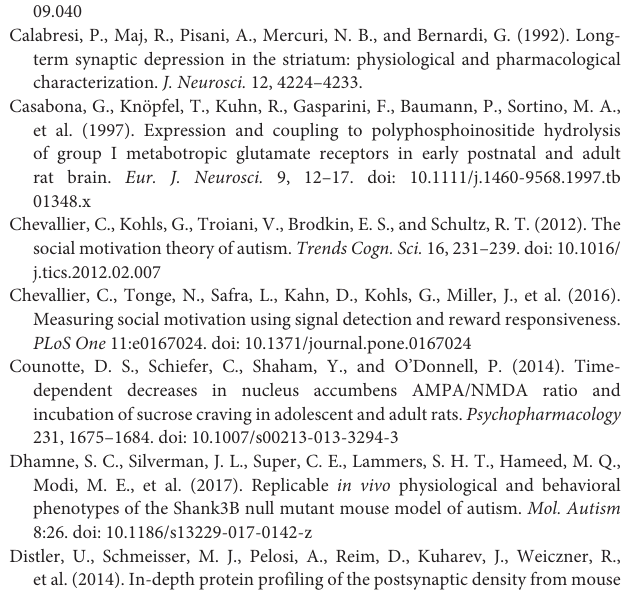
TABLE S1 | Comprehensive statistics